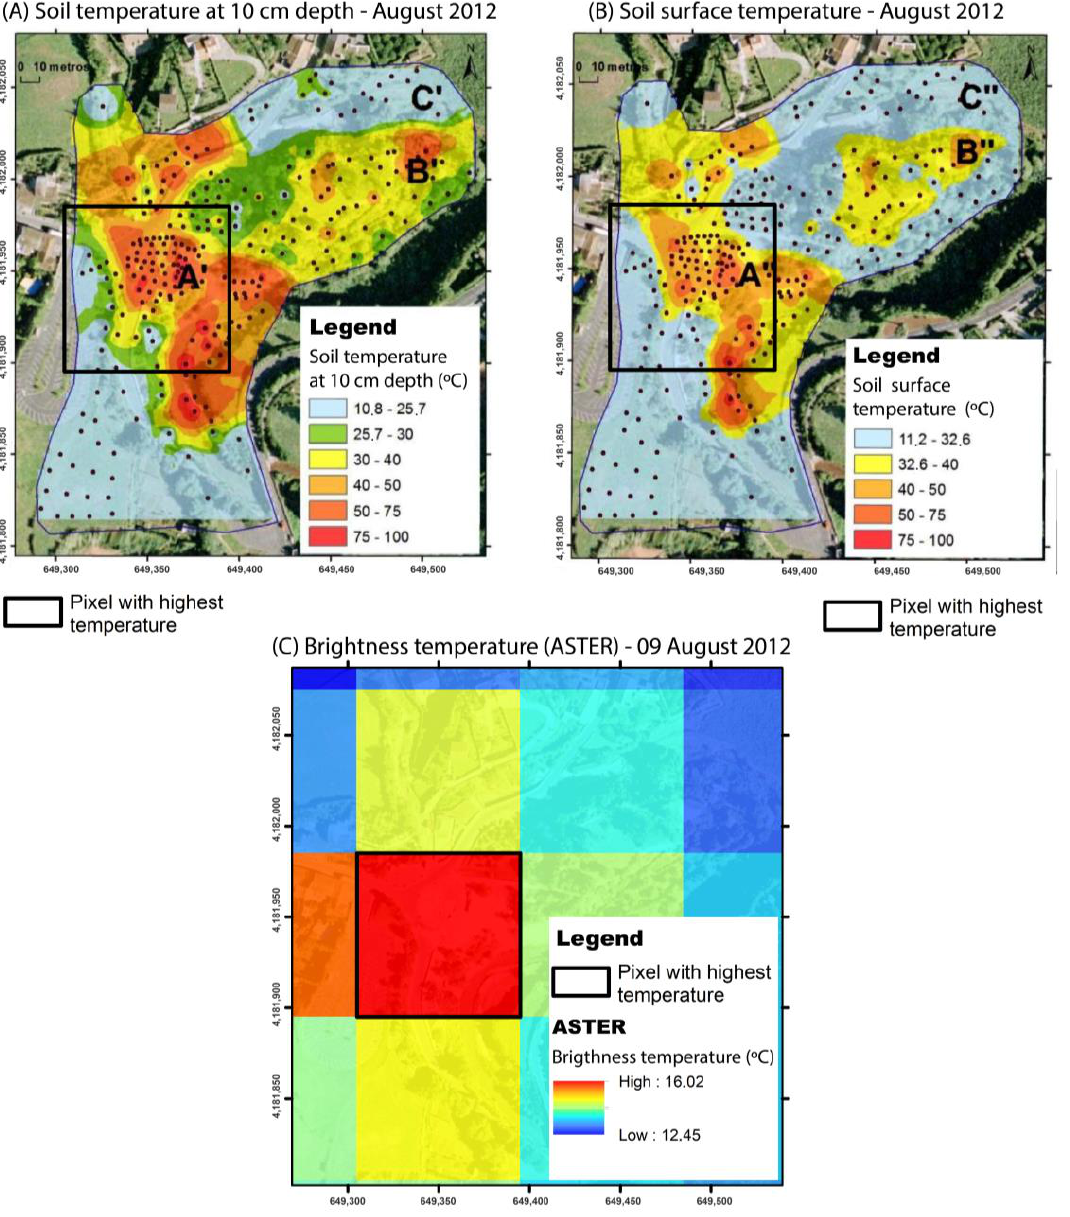
Figure 6. Comparison between temperature ( A ) in the soil at a depth of 10 cm (Pacheco, 2013), ( B ) on the ground surface in situ (Pacheco, 2013), and ( C ) measured using the ASTER sensor in the area comprising the Furnas hydrothermal fumaroles.